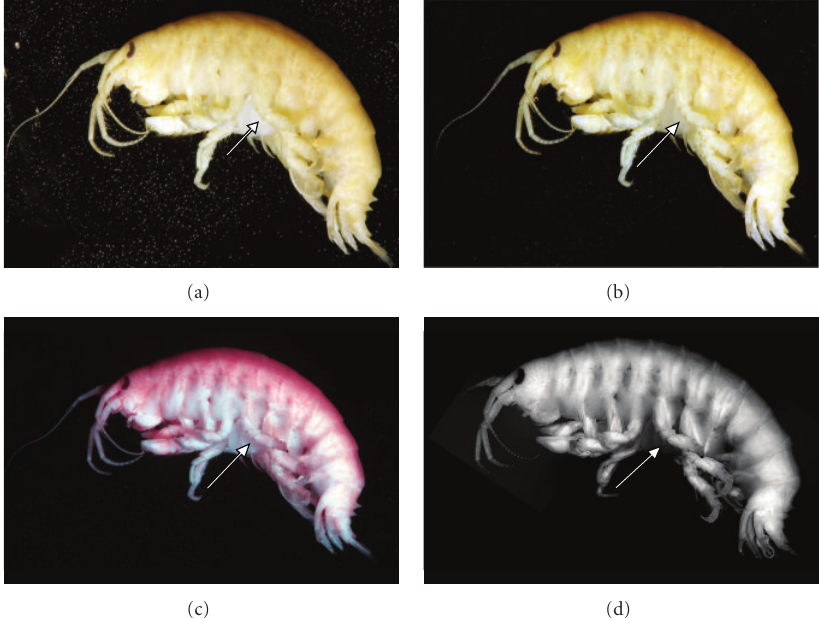
Figure 2: Comparison of di ff erent methods applied to an entire specimen of Dikerogammarus villosus stored in alcohol. All images are fused from several focal planes. (a)–(c) Macrographs. (a) “Normal” macrograph, with optimized uniform light. Bubbles are evident on the black velvet, which was used as background. Due to reflections, individual elements of the limbs are di ffi cult to distinguish (arrow). (b) Macrograph under polarized light. Bubbles are not apparent. Borders between individual elements of the limbs more conspicuous (arrow). (c) Macrofluorescence. Borders between individual limb elements are well apparent due to the color contrast (arrow). (d) Composite fluorescence image [4]. Details well contrasted, also the individual limb elements